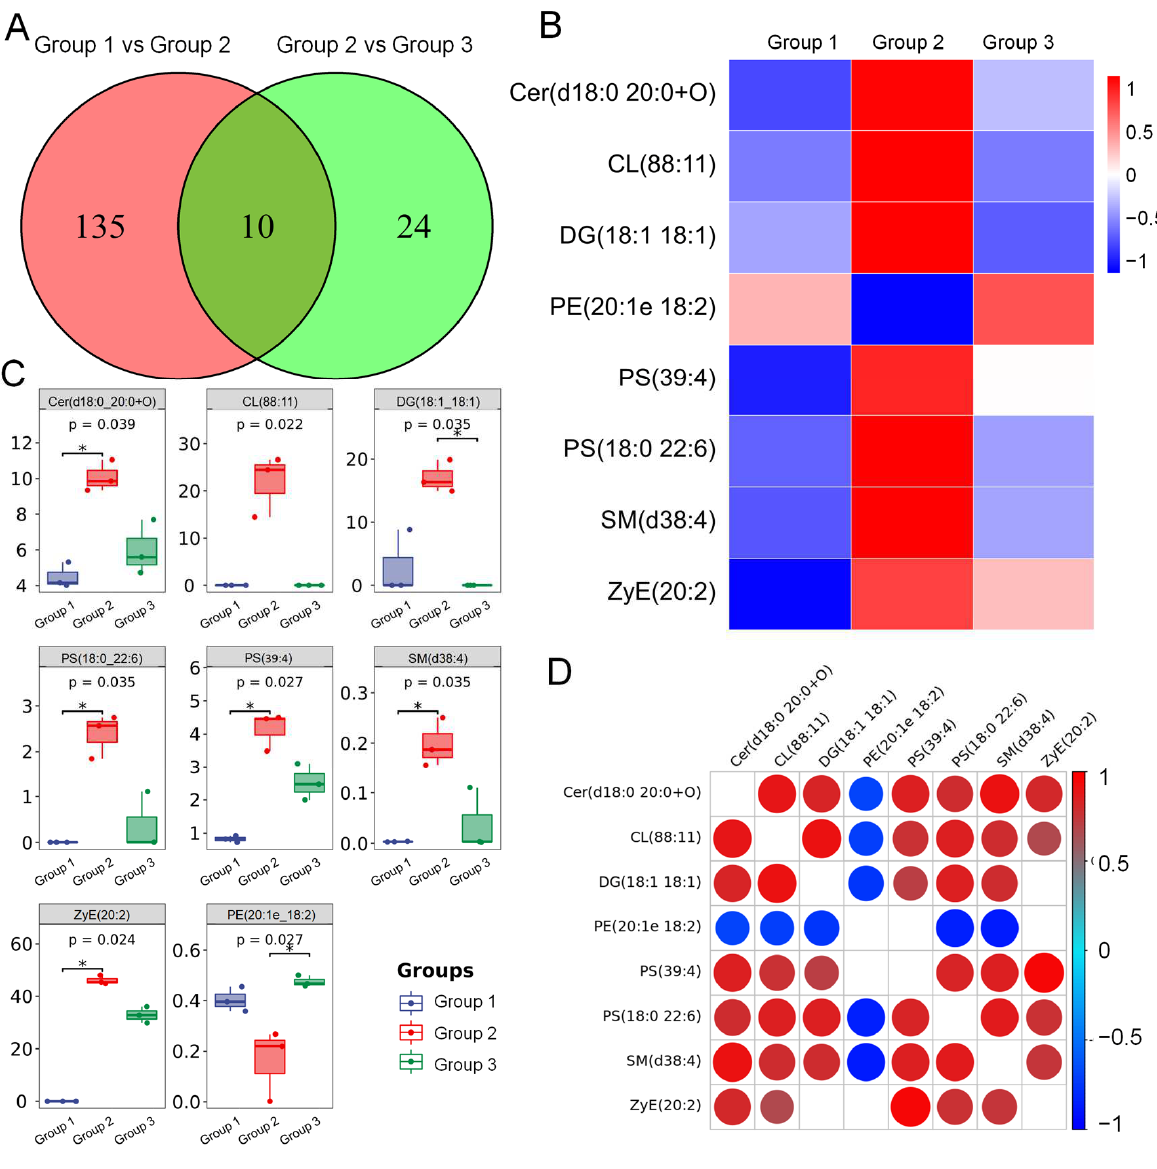
Figure 5. ADe treatment regulated the lipid metabolites in HFD-fed mice. ( A ) Venn diagram of significantly altered metabolites. ( B ) Heatmap and ( C ) box-plot of eight significantly altered metabolites in ADe-treated HFD-fed mice (n = 3). * p < 0.05 versus HFD-fed mice. ( D ) Correlation heatmap of eight significantly altered metabolites based on the Pearson correlation. Red means positive correlation and blue means negative correlation. The larger the circle, the stronger the significance. Cer, Ceramide; CL, Cardiolipin; DG, Diacylglycerol; PE, Phosphatidylethanola; PS, Phosphatidylserine; SM, Sphingomyelin; ZyE, Zymosterol. Group 1: NCD-fed mice, Group 2: HFD-fed mice, Group 3: ADe-treated HFD-fed mice.